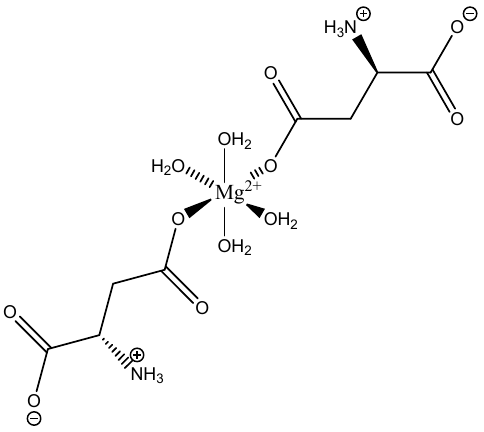
Figure 19. Illustrated structure of the magnesium bis (hydrogenaspartate) tetrahydrate structure reported by Schmidbaur et al. [65,109].